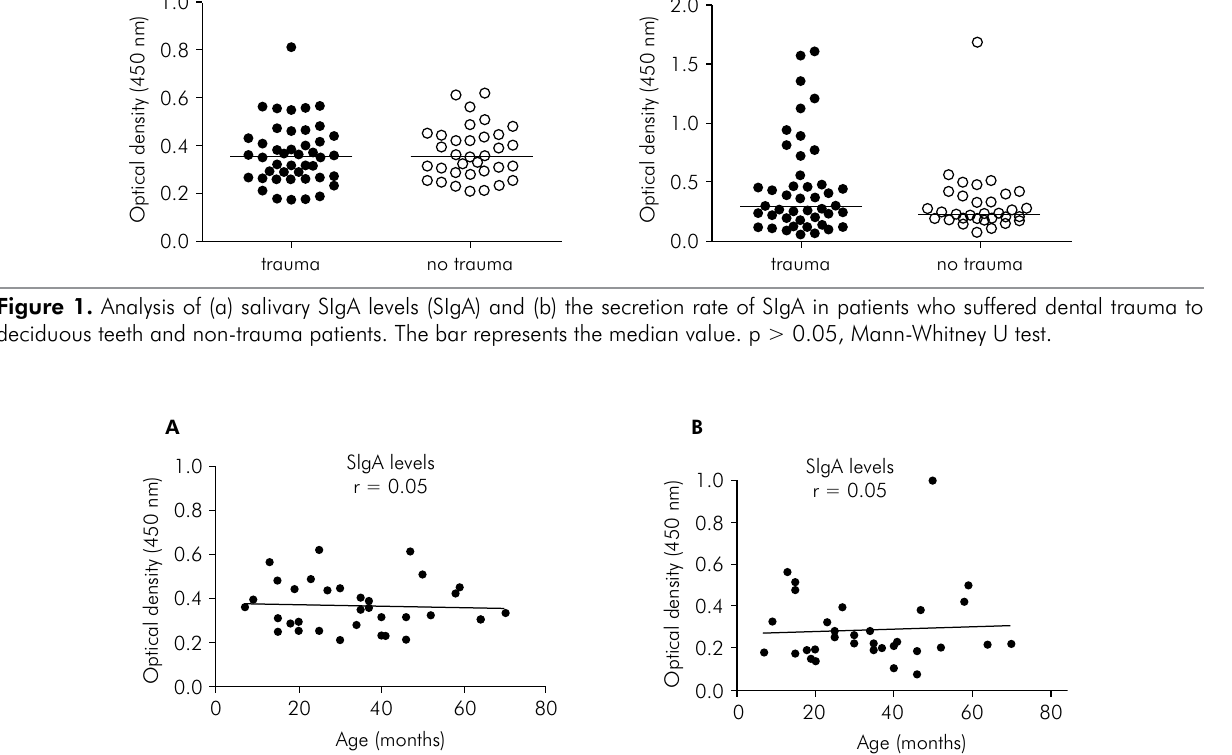
Figure 2. Correlation between (a) anti-dentin SIgA level and (b) secretion rate with age of dental trauma onset. Spearman’s correlation